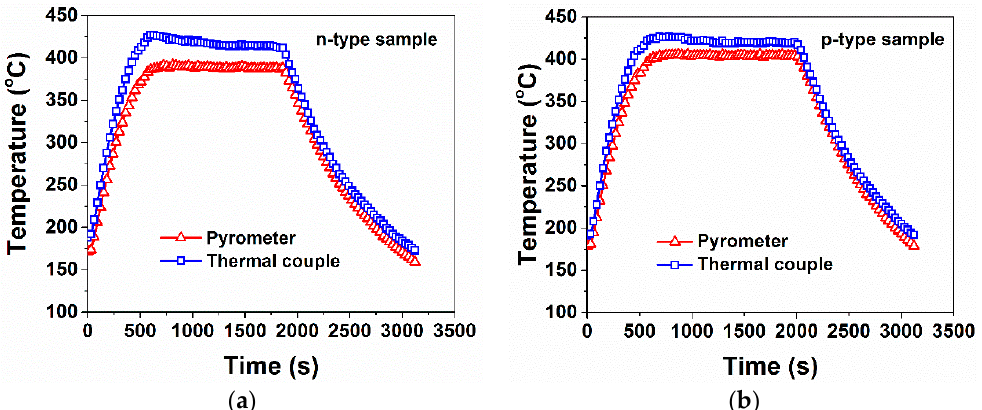
Figure A2. Temperature profile of pyrometer and thermal couple of ( a ) the n-type sample and ( b ) the p-type sample.